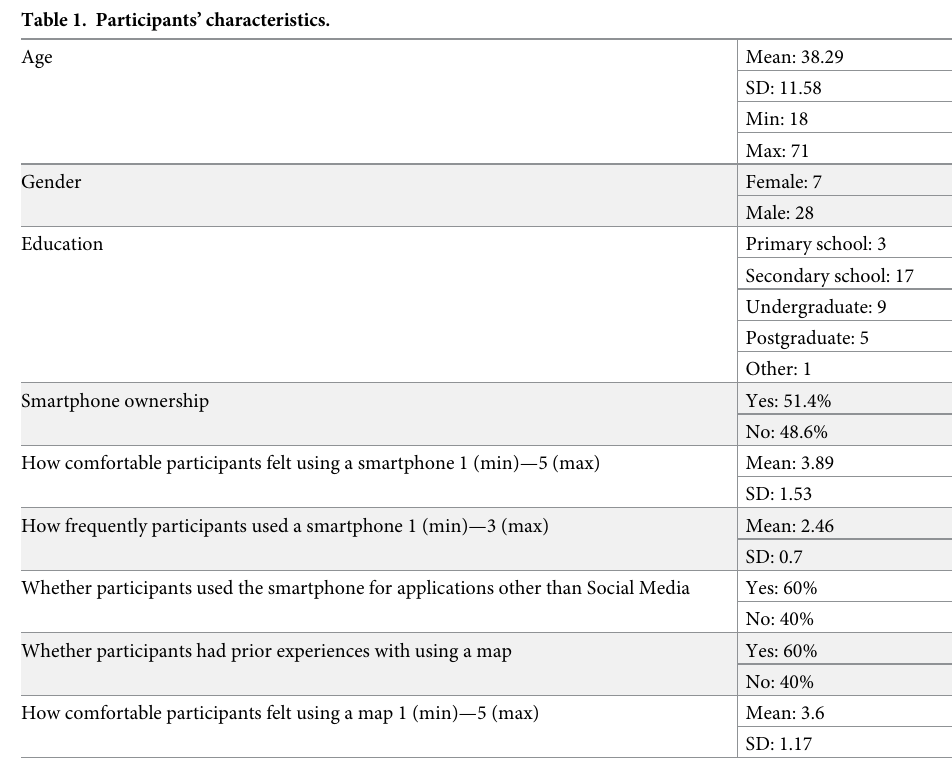
Table 1. Participants’